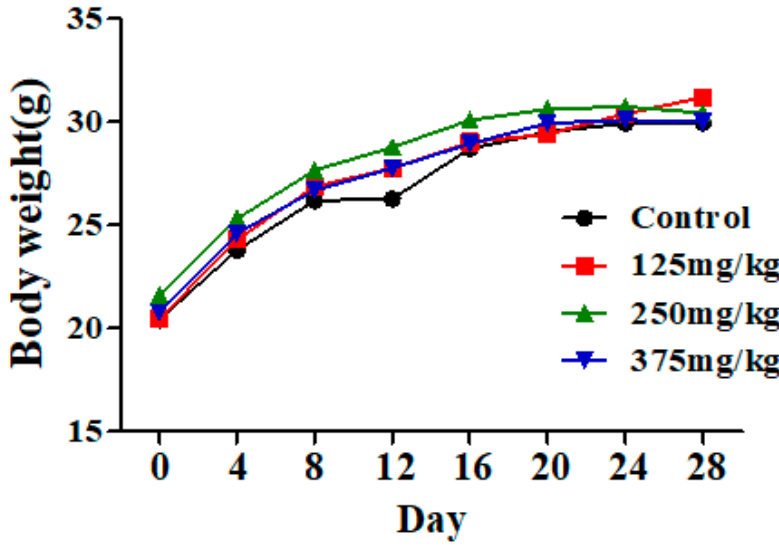
Figure 1. Effect of DEHP exposure on the body weight of mice ( n = 10). The result showed that the body weight of mice in the control group and DEHP-exposed groups exhibited no significant changes. Data represented as means.